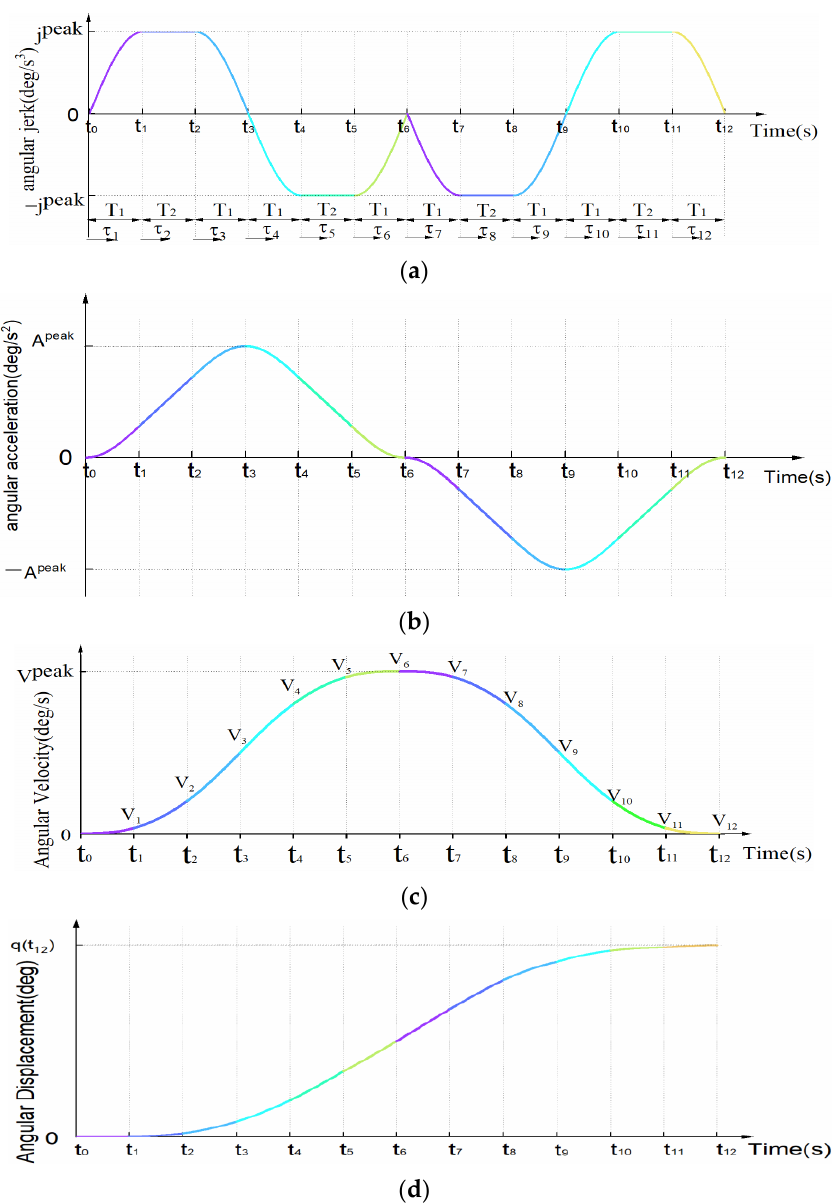
Figure 3. 12-phase sine jerk motion profile: ( a ) angular acceleration rate − time curve, ( b ) angular acceleration − time curve; ( c ) angular velocity − time curve, and ( d ) angular displacement − time